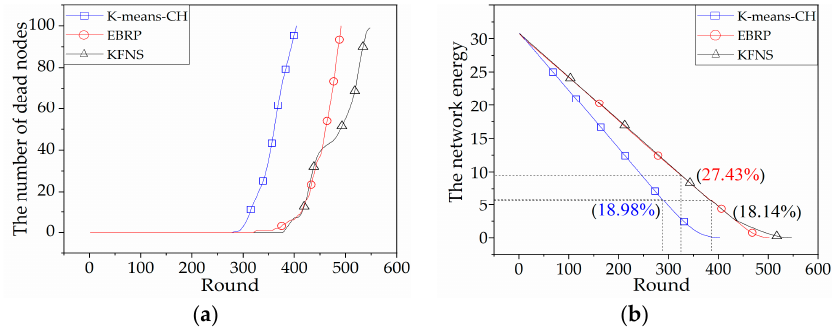
Figure 9. ( a ) The curves of dead node number by rounds; ( b ) network energy consumption.